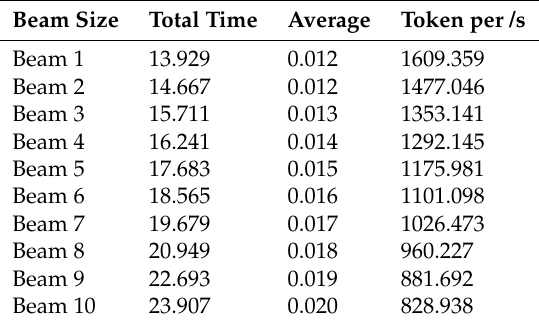
Table 4. Decoding speed according to beam size.